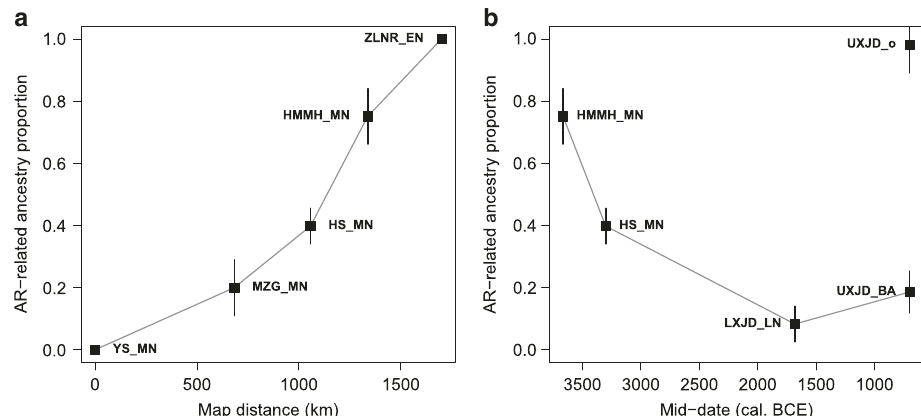
Fig. 3 qpAdm modeling of the ancient populations in Northern China. Modeling ancient populations as a mixture of YR_MN and AR_EN. a Middle Neolithic populations in this study. X -axis shows the great circle distance from the YR_MN sites and y -axis shows estimates of AR-related ancestry proportion (represented by AR_EN). b WLR populations from Middle Neolithic to Bronze Age. Black squares represent the point estimates. Vertical bars represent ± 1 s.e.m. range, estimated by 5 cM block jackkni fi